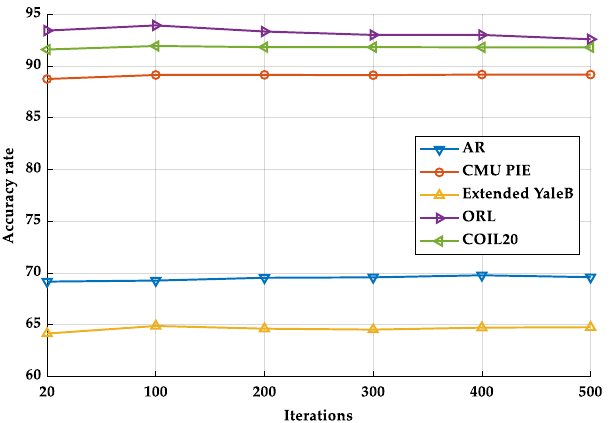
Figure 5. Accuracy rate of the proposed RMFRASL method on each database with different iteration. Table 6. The optimal combination of parameters and dimension on the classification task.